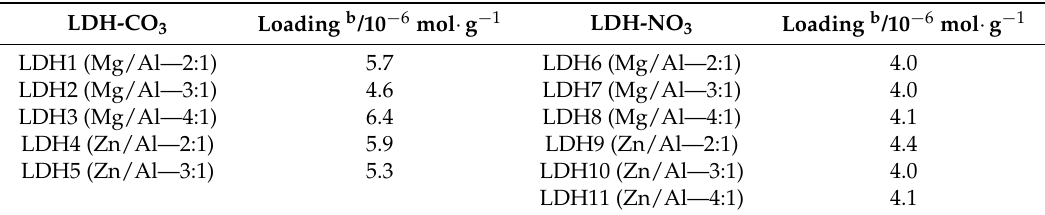
Table 4. Loading values calculated for the solids obtained after immobilization of 100% MnP on the prepared LDHs a